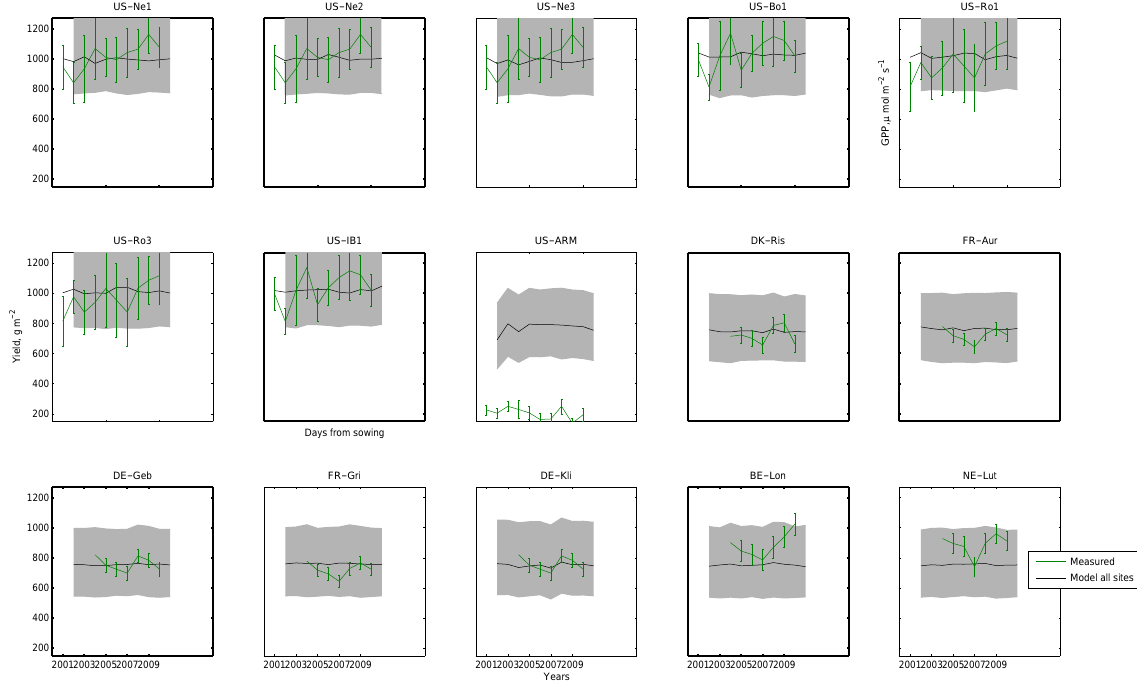
Figure A6. Yield predictions for all years for all sites fitted using all available data at a subset of sites for model evaluation. Sites with black boxes have been used in the model fitting. Grey shaded areas represent 95% confidence intervals drawn from the posterior